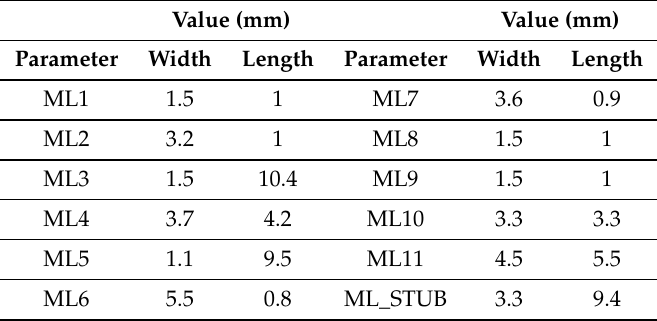
Figure 4. Topology of the dual-band rectifier. Table 2. Rectifier circuit